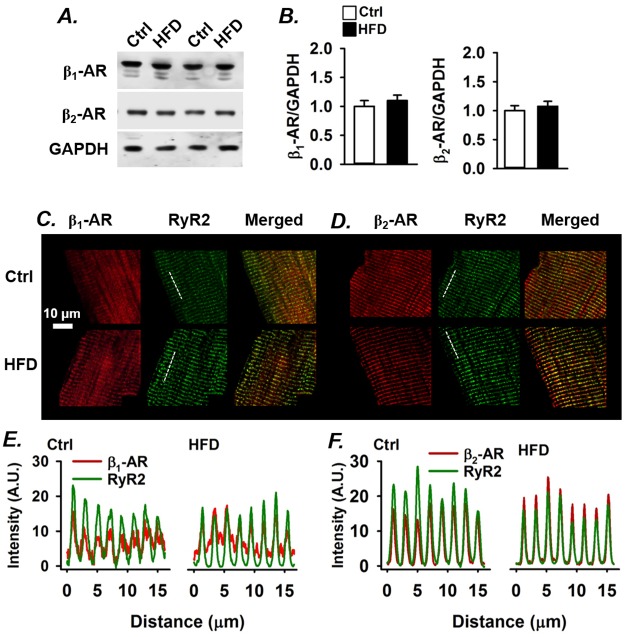
Cardiomyocytes from mice with the metabolic syndrome show normal β1-AR, β2-AR expression and distribution.(A) Representative Western blots and mean data ± SEM (B; n = 6) of total expression of β1- and β2-ARs in left ventricles from control mice and HFD mice. Immunofluorescence staining of β1-AR (C) and β2-AR (D) co-stained with RyR2 in control and HFD cardiomyocytes. Merged (yellow) show the intensity overlap between β-ARs and RyR2 in the dyads. E and F show plotted intensity profiles of along the dashed lines in C and D with β-AR (red) and RyR2 (green).